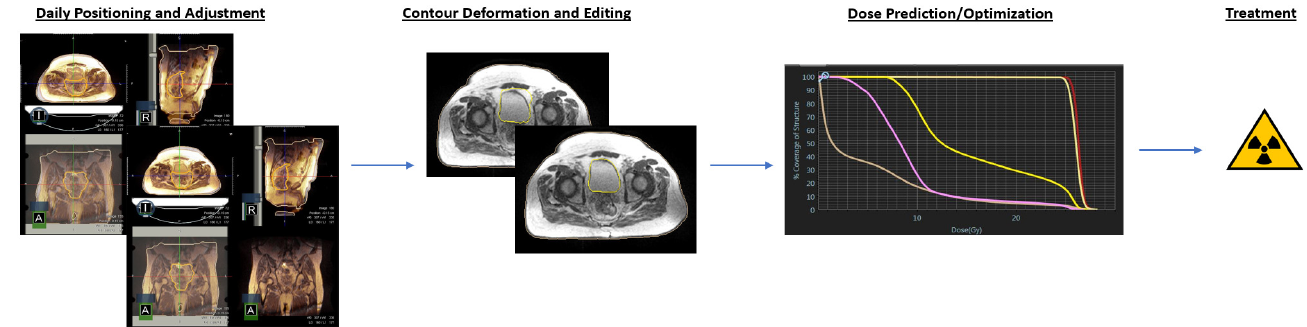
Figure 1. General workflow for ATP adaptive therapy. First, a daily scan is taken and discrepancies between the daily and planning images are corrected. This is represented in the first pair of images on the left. OAR contours are then deformed and corrected. Target contours are rigidly copied to the day’s image. Dose from the plan is predicted given the daily images and reoptimized as needed. Once approved, treatment proceeds.